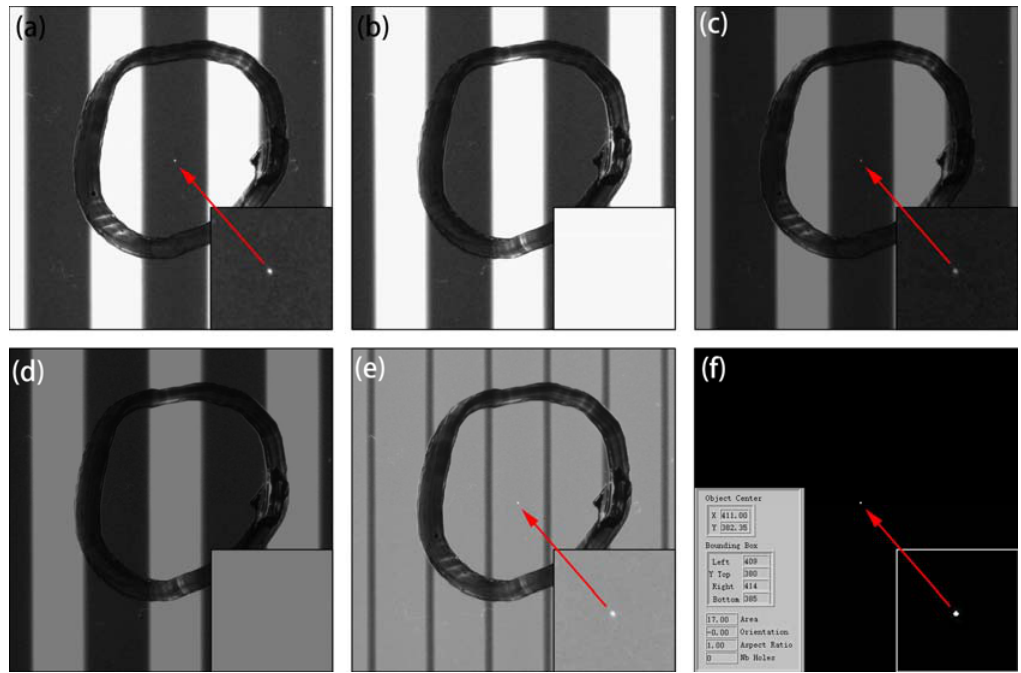
Figure 6. Processed images for an indentation defect sample: ( a , b ) sequential two ‐ step original images; ( c , d ) gray value divided by 2; ( e ) superposition image; ( f ) binary image and defect extraction.